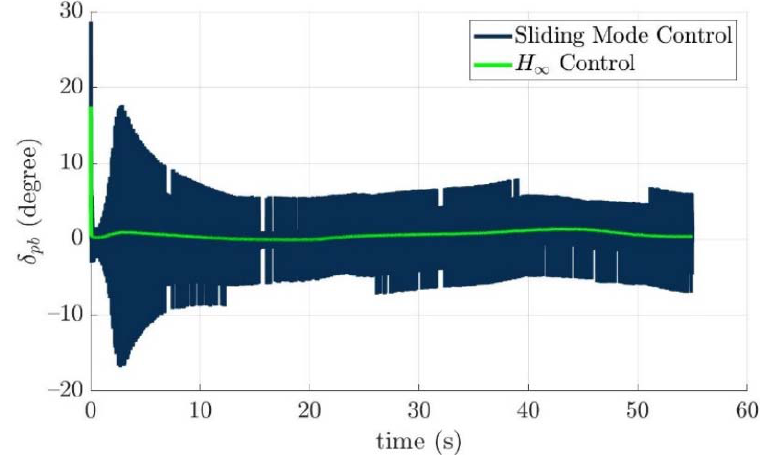
Figure 25. The port bow fin angles of the controlled torpedo-like underwater vehicle for two control laws, respectively.